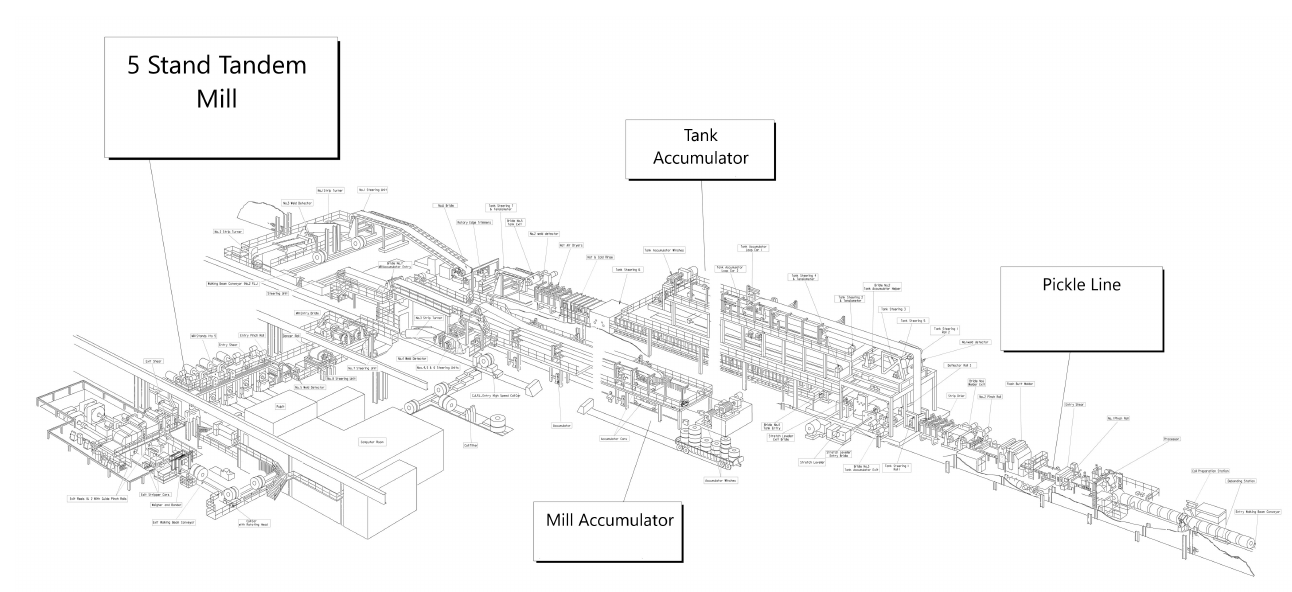
Figure 3. The big picture of the cold rolling processes at the Port Talbot plant provided by Tata Steel. Copyright © 2021 all rights